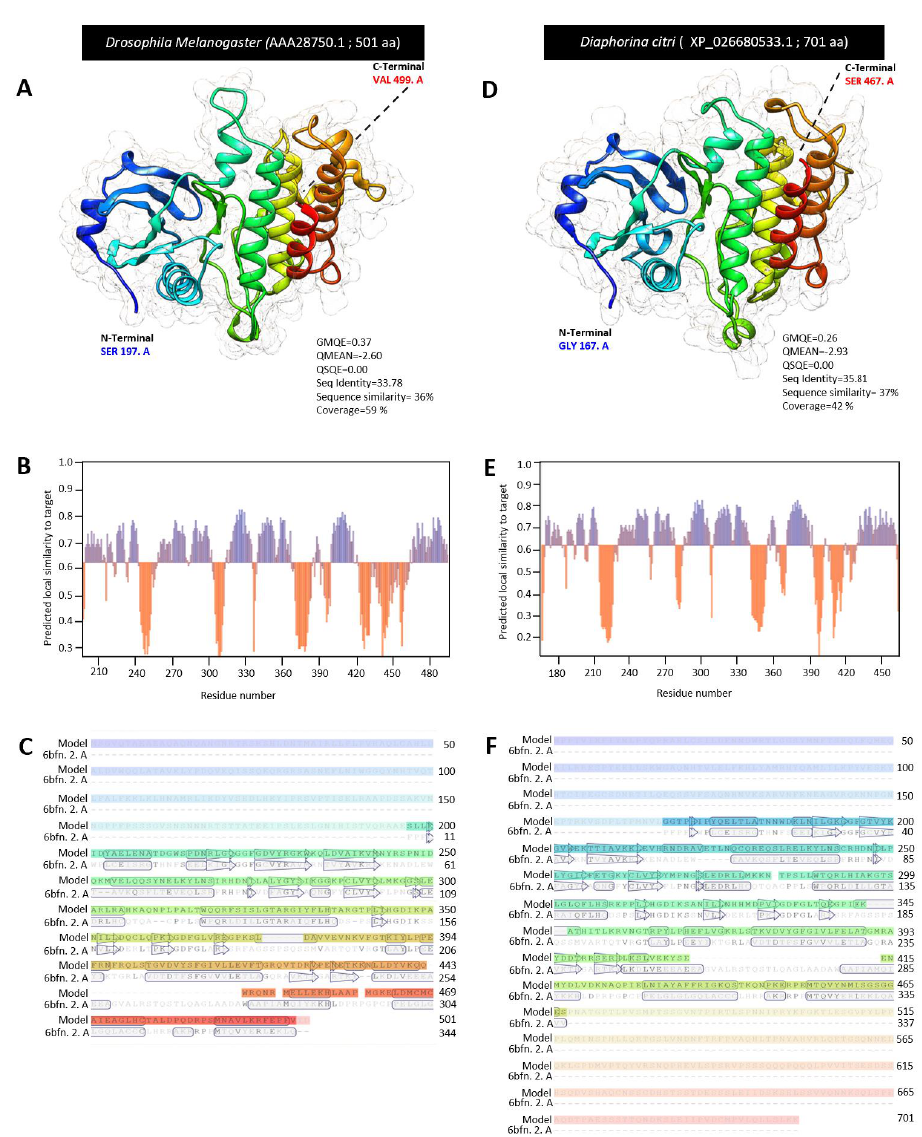
Figure 2. The crystallographic three-dimensional (3D) modeling of Pelle protein of D. citri. ( A , D ) The predicted three-dimensional (3D) structure model and its associated mesh surface of DmPelle (AAA28750.1), DcPelle (XP_026680533.1), respectively. The tertiary structures were predicted with the common template of crystal structure of human interleukin-1 receptor-associated kinase1 (also known as the crystal structure of human IRAK1) in the Protein Data Bank (PDB ID: 6bfn.2. A) between D. citri and D. melanogaster with 2.26 Å resolution. Protein chains are colored according to the rainbow color spectrum from blue (N-terminal) to the red (C-terminal). ( B , E ) Model – template alignment of DmPelle and DcPelle, respectively. Amino acid sequences of each model were aligned with template 6bfn.2. A. Secondary structure of each model are presented by α -helices (rectangles) and β -pleated sheets (arrows). Matched sequences in alignment are presented in black. ( C , F ) Local quality estimate of the predicted models of DmPelle and DcPelle, respectively. All bioinformatic analyzes were accomplished based on the most recent data available in GenBank, the National Center for Biotechnology Information website (NCBI, http://www.ncbi.nlm.nih.gov/gene/, accessed on 12